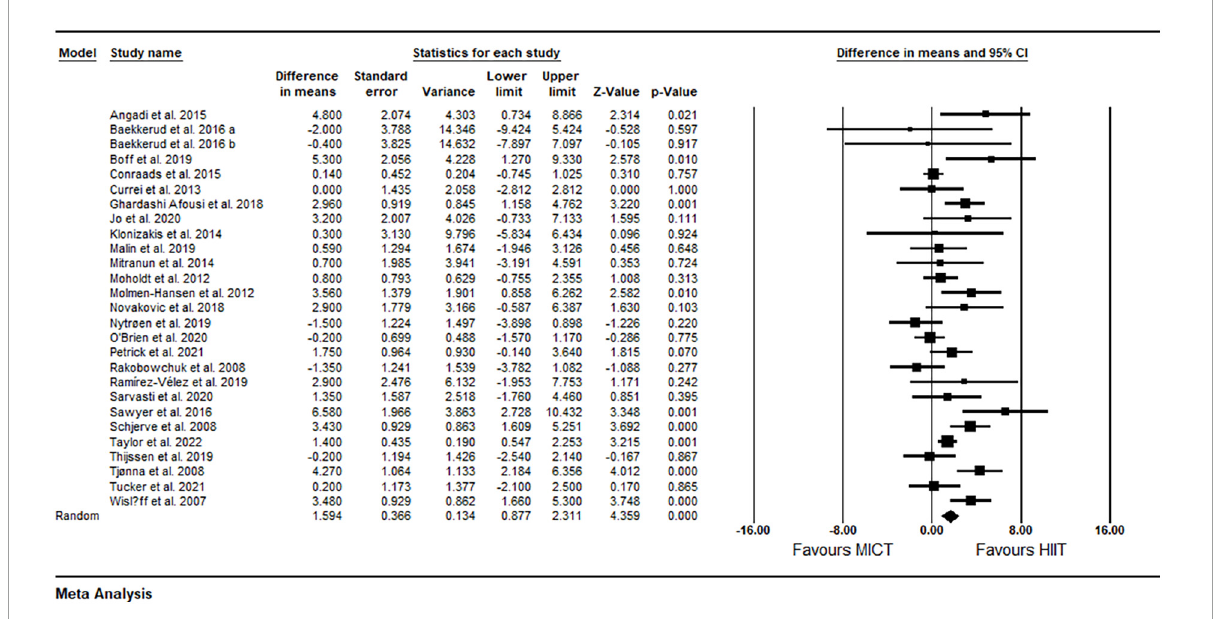
FIGURE2 Forest plot of the effects of HIIT vs. MICT on FMD. Data are reported as WMD (95% confidence limits). FMD, brachial artery flow-mediated dilation; WMD, weighted mean differences.